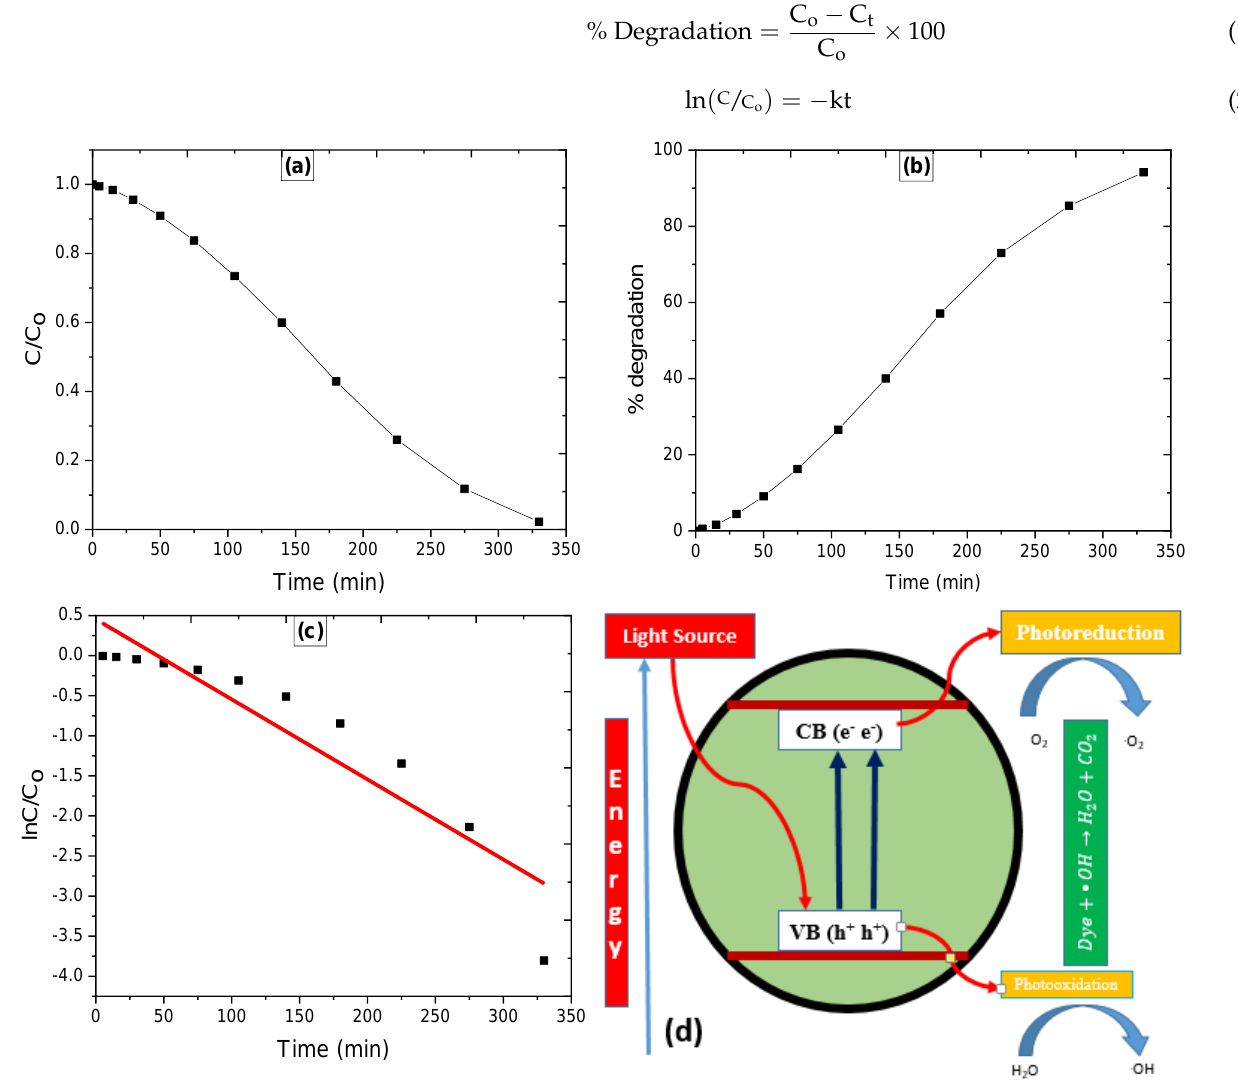
Figure 9. Photocatalytic parameters including, ( a ) = degradation profile, ( b ) = percentage degradation, ( c ) = kinetic plot and ( d ) = electron excitation and hole creation mechanism.